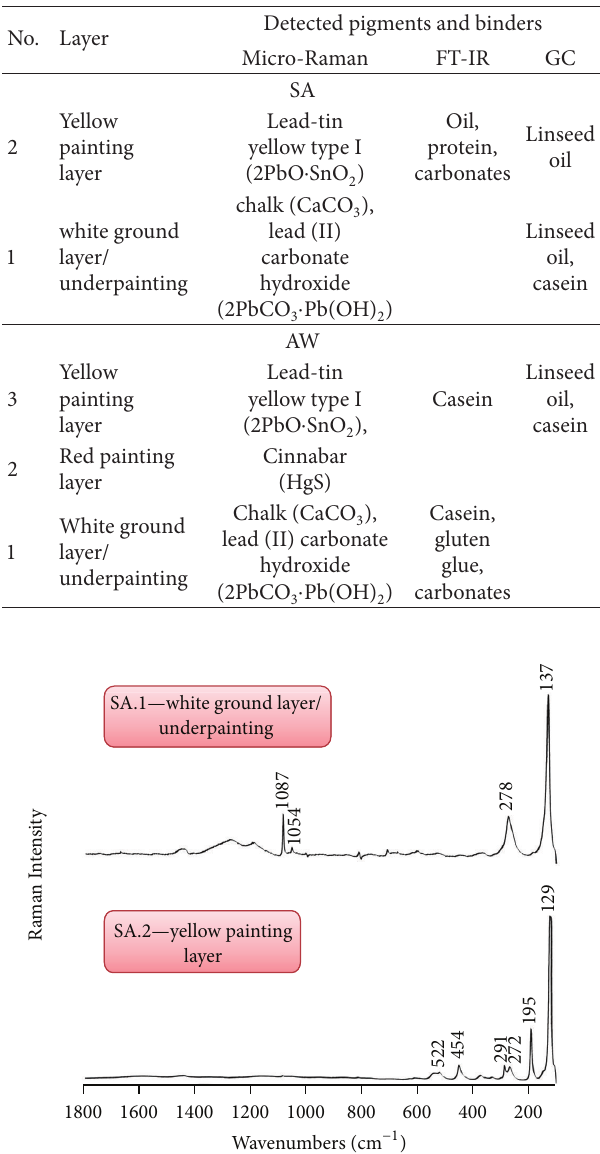
Figure 3: Micro-Raman spectra of the cross-section layers of “Ser- vilius Appius” (SA).